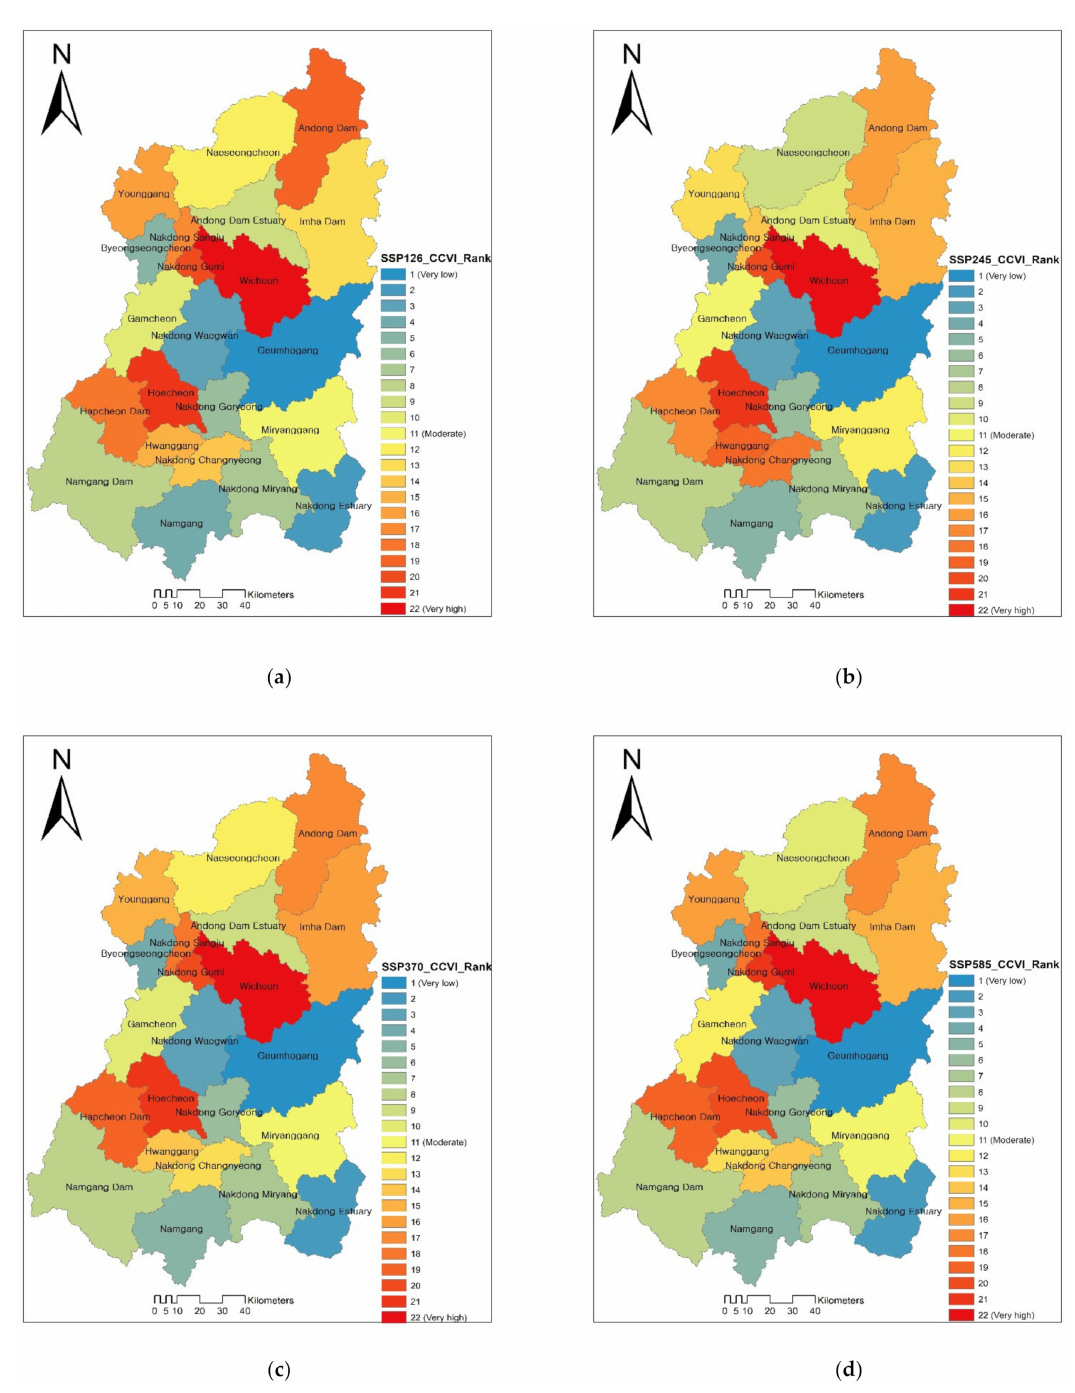
Figure 3. Spatial distribution of CCVI by Nakdong River sub-watershed (the closer to blue, the higher the CCVI, the lower the vulnerability to climate change; and the closer to red, the lower the CCVI and the higher the vulnerability to climate change). ( a ) ssp-126, ( b ) ssp245, ( c ) ssp-370, and ( d )